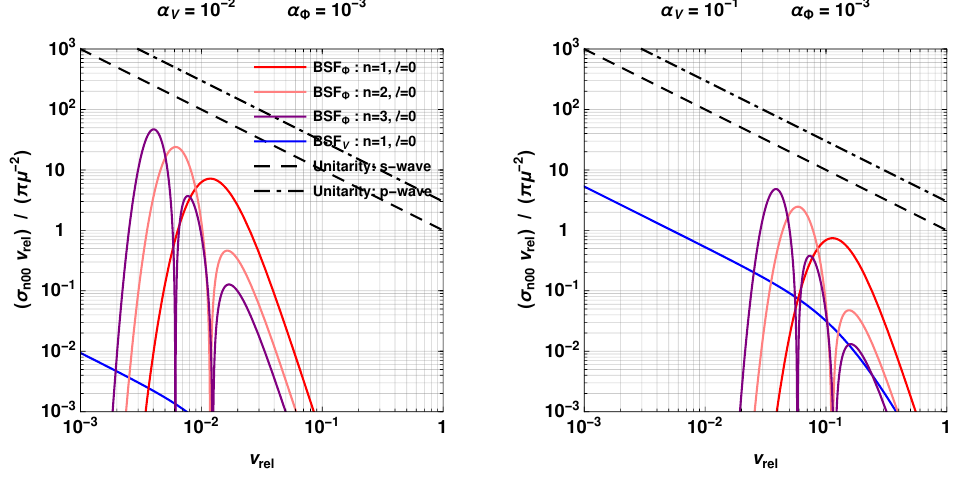
Figure 5 . The velocity-weighted cross-section for capture into zero-angular momentum XX y bound states, n 00: XX ! B n 00 ( XX y ) + (cid:8) for n = 1 ; 2 ; 3, and XX y ! B 100 ( XX y ) + V . For V emission,